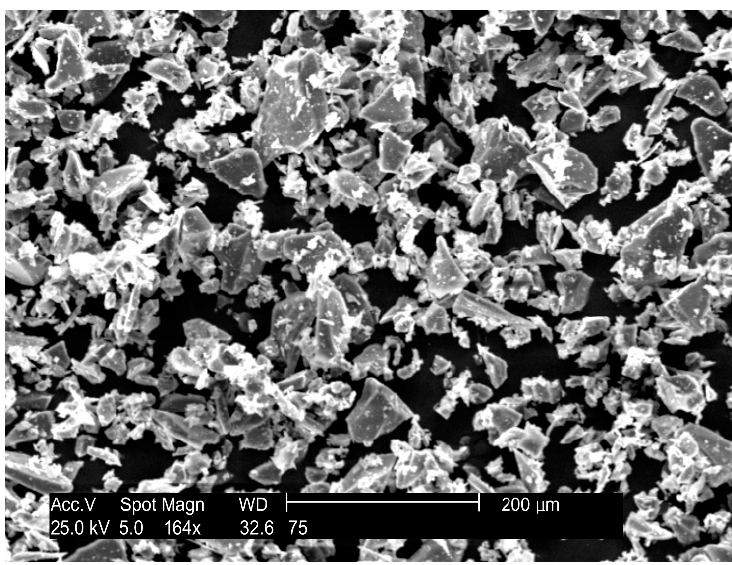
Figure 2. Scanning electron microscopy (SEM) analysis of the glass powder.